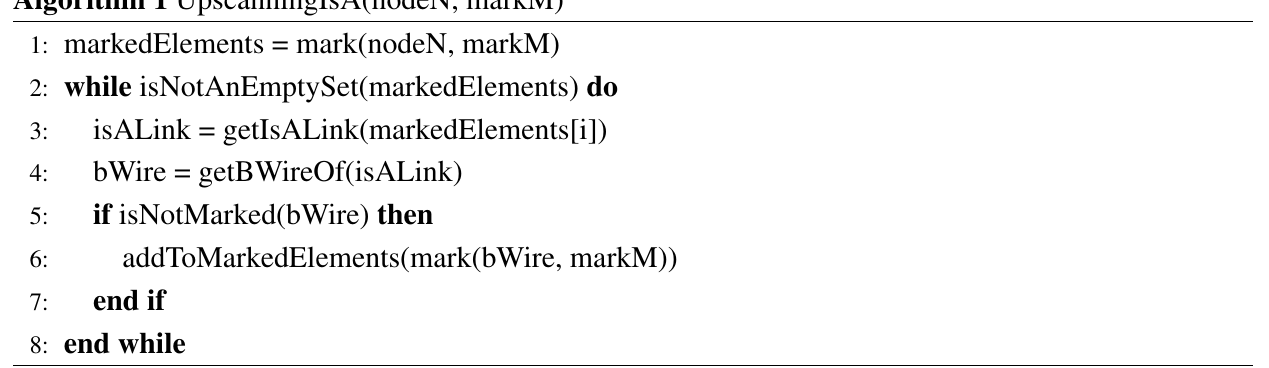
Algorithm 1 UpscanningIsA(nodeN, markM)